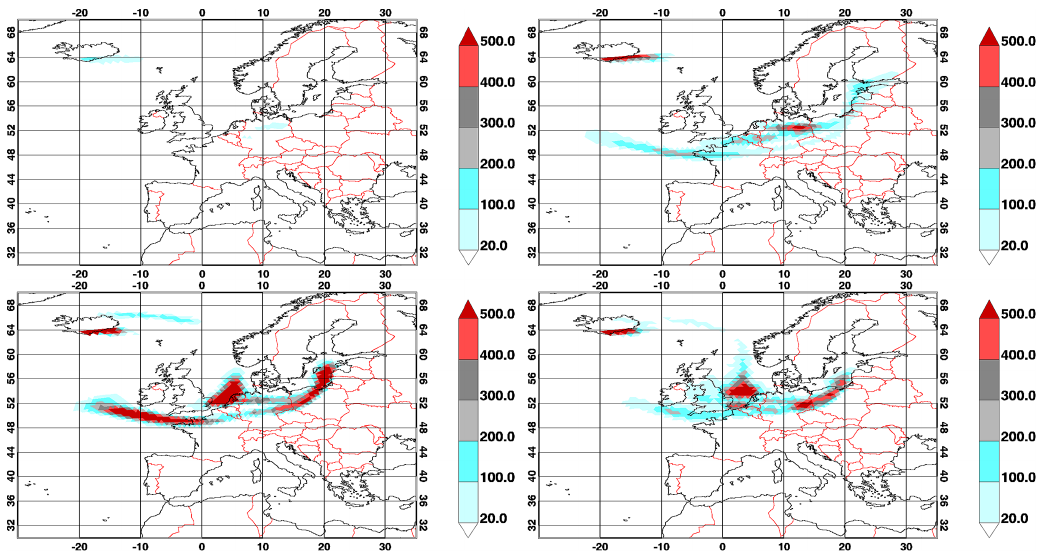
Figure 9. Horizontal distribution of the volcanic ash concentrations in µgm − 3 at 16 April 2010, 12:00UTC. Top left: at about flight level F350 (10668m). Top right: at about flight level F200 (6096m). Bottom left: at about 2300m. Bottom right: at about 1160m.